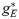
Age dependency of best fit model excitation, gE*, (a,c,e), and inhibition, gI*, (b,d,f).(a-d) Best fit model parameters estimated from experimental spike trains divided into three week interval datasets versus mean age of dataset. (a,b) YACWT (black circles), YACHD (red crosses), (c,d) Q175WT (green circles), Q175Het (blue crosses), Q175Hom (pink squares). (e-f) Model parameters estimated from experimental spike trains divided into datasets from individual animals versus mean age of dataset. R62WT (orange circles), R62HD (dark green crosses). (a-e) Bars show weighted standard errors in estimated quantities (see Methods). Lines show linear regression fits to YACWT (black), YACHD (red), Q175WT (green), Q175Het (blue), R62WT (orange), R62HD (dark green), plotted data, using errors in both x and y co-ordinates (see Methods). Insets show slopes and standard errors in the estimated slope (see Methods). p-values for the significance of difference of regression slope from zero calculated from two-tailed t-test are (a) YACWT, 0.011 (*), YACHD 0.017 (*), (b) YACWT 0.938, YACHD 0.001 (**), (c) Q175WT 0.25, Q175Het 0.006 (**), (d) Q175WT 0.879, Q175Het 0.057, (e) R62WT 0.660, R62HD 0.302, (f) R62WT 0.212, R62HD 0.252. (* denotes p < 0.05, ** denotes p < 0.01). (a,b) Pink arrows indicate the YAC datasets WT75 and HD12 whose heat maps are shown in Fig 6(h) (WT75) and Fig 6(i) (HD12) and whose ISI spike characteristics are shown in Figs 8, 9(a), 9(c) and 9(e).